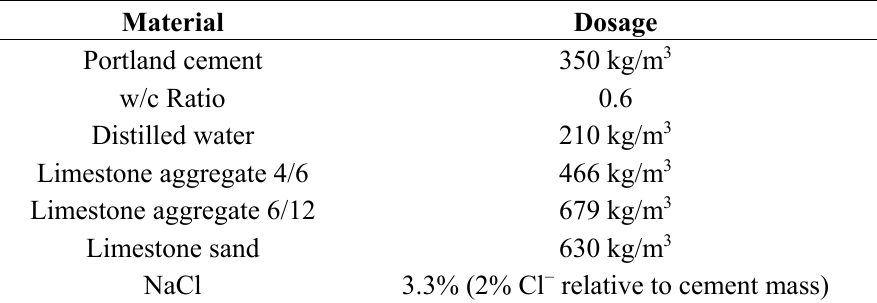
Table 1. Dosage of the concrete for laboratory specimens.